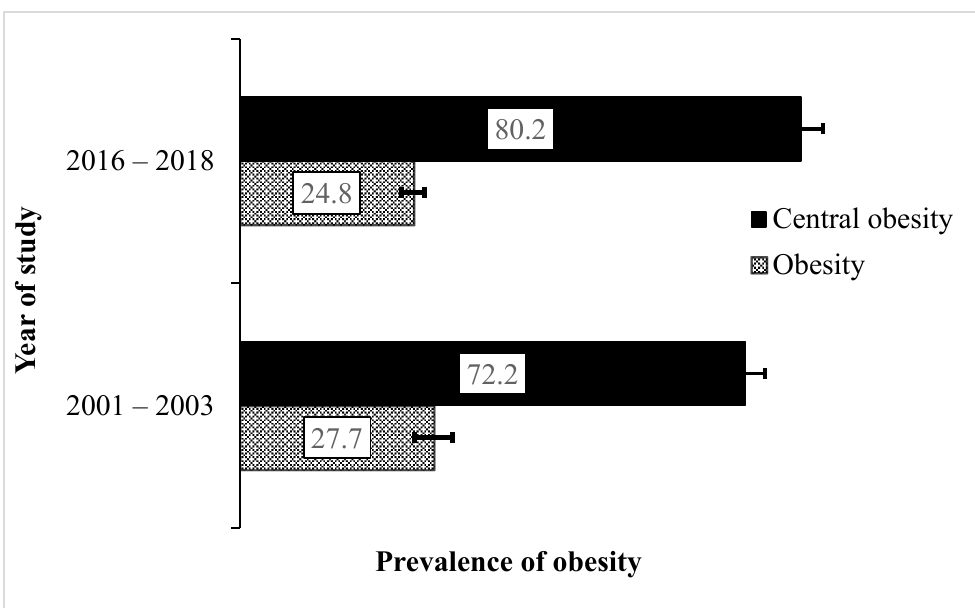
Figure 1. Trends in prevalence (%) and 95% confidence interval of obesity in the smaller towns surveyed in Victoria (2001–2018). General and central obesity measures were determined by body mass index and waist circumference, respectively.